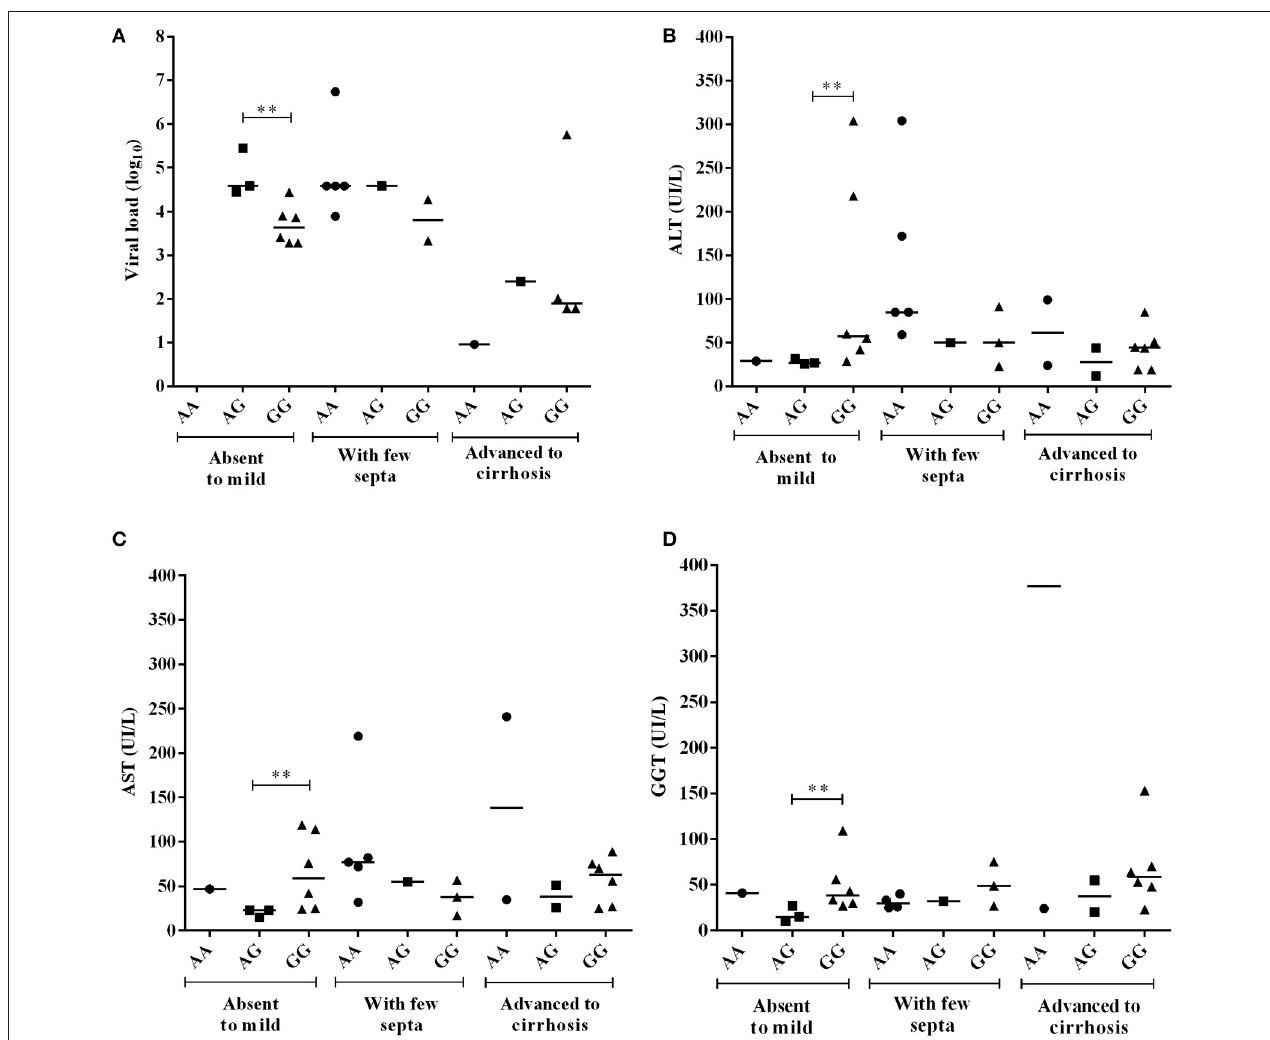
FIGURE 6 | Comparison of plasma viral loads (log 10 ) and liver enzyme levels among CHB-A patients with − 924A > G polymorphism genotypes according to the degree of liver fibrosis. All comparisons were significant (A–D) at the absent to mild fibrosis stages